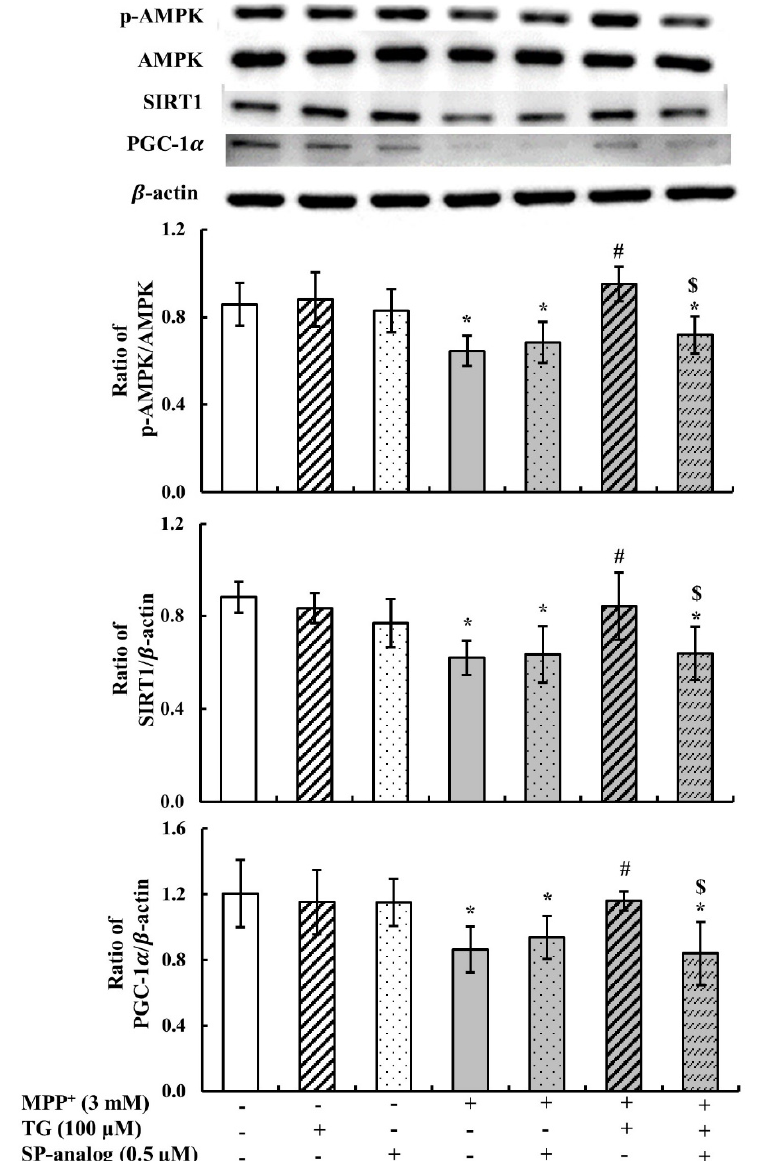
Figure 7. Teaghrelin (TG) attenuated 1-methyl-4-phenylpyridinium (MPP + )-induced neurotoxicity through activated AMP-activated protein kinase (AMPK) / sirtuin 1(SIRT1) / peroxisome proliferator-activated receptor gamma (PPAR γ ) coactivator-1 α (PGC-1 α ). SH-SY5Y cells were treated with TG, SP-analog, respectively, in the presence or absence MPP + for 24 h. Cells were harvested and determined by Western blotting using antibodies against AMPK, p-AMPK, SIRT, PGC-1 α . The expression of β -actin was used as internal control. Values are presented as mean ± SD (n = 4). * p < 0.05 compared with control group, # p < 0.05 compared with MPP + alone. $ p < 0.05 compared with MPP + + TG group. -: untreated with drugs or compounds, +: treated with drugs or compounds.